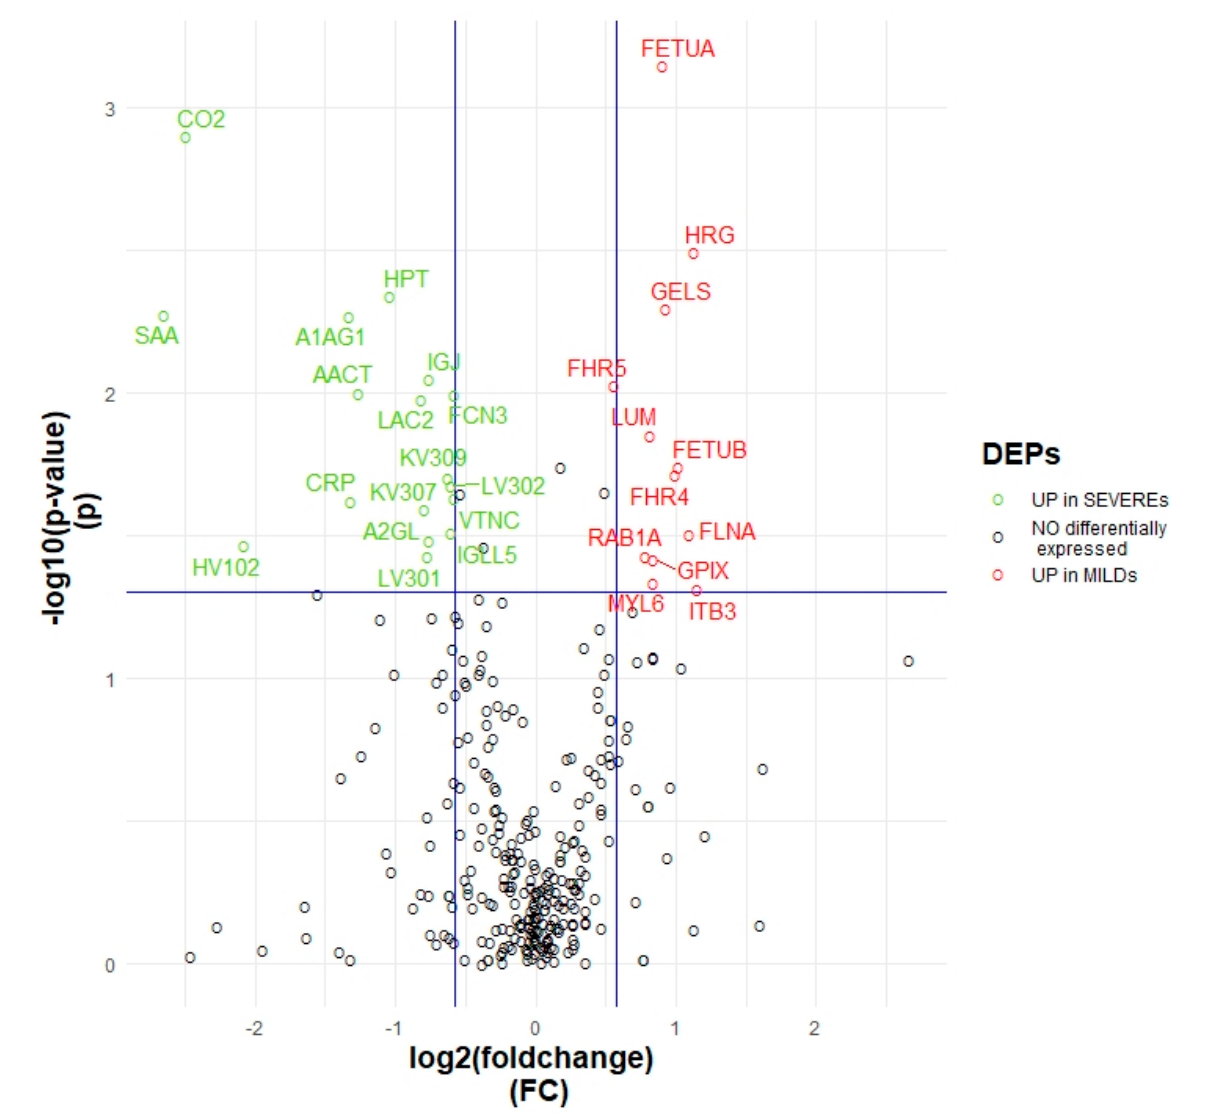
Figure 1. Volcano plot. Volcano plot showing which proteins are significantly deregulated between MILDs and SEVEREs considering a p -value ( p ) ≤ 0.05 and a fold change threshold of ± 1.5. 17 proteins, in green, are upregulated in SEVEREs (Fold change ≤ − 1.5); while 12 proteins, in red, are up- regulated in MILDs (Fold change ≥ 1.5). Proteins are reported as UNIPROT_ID.